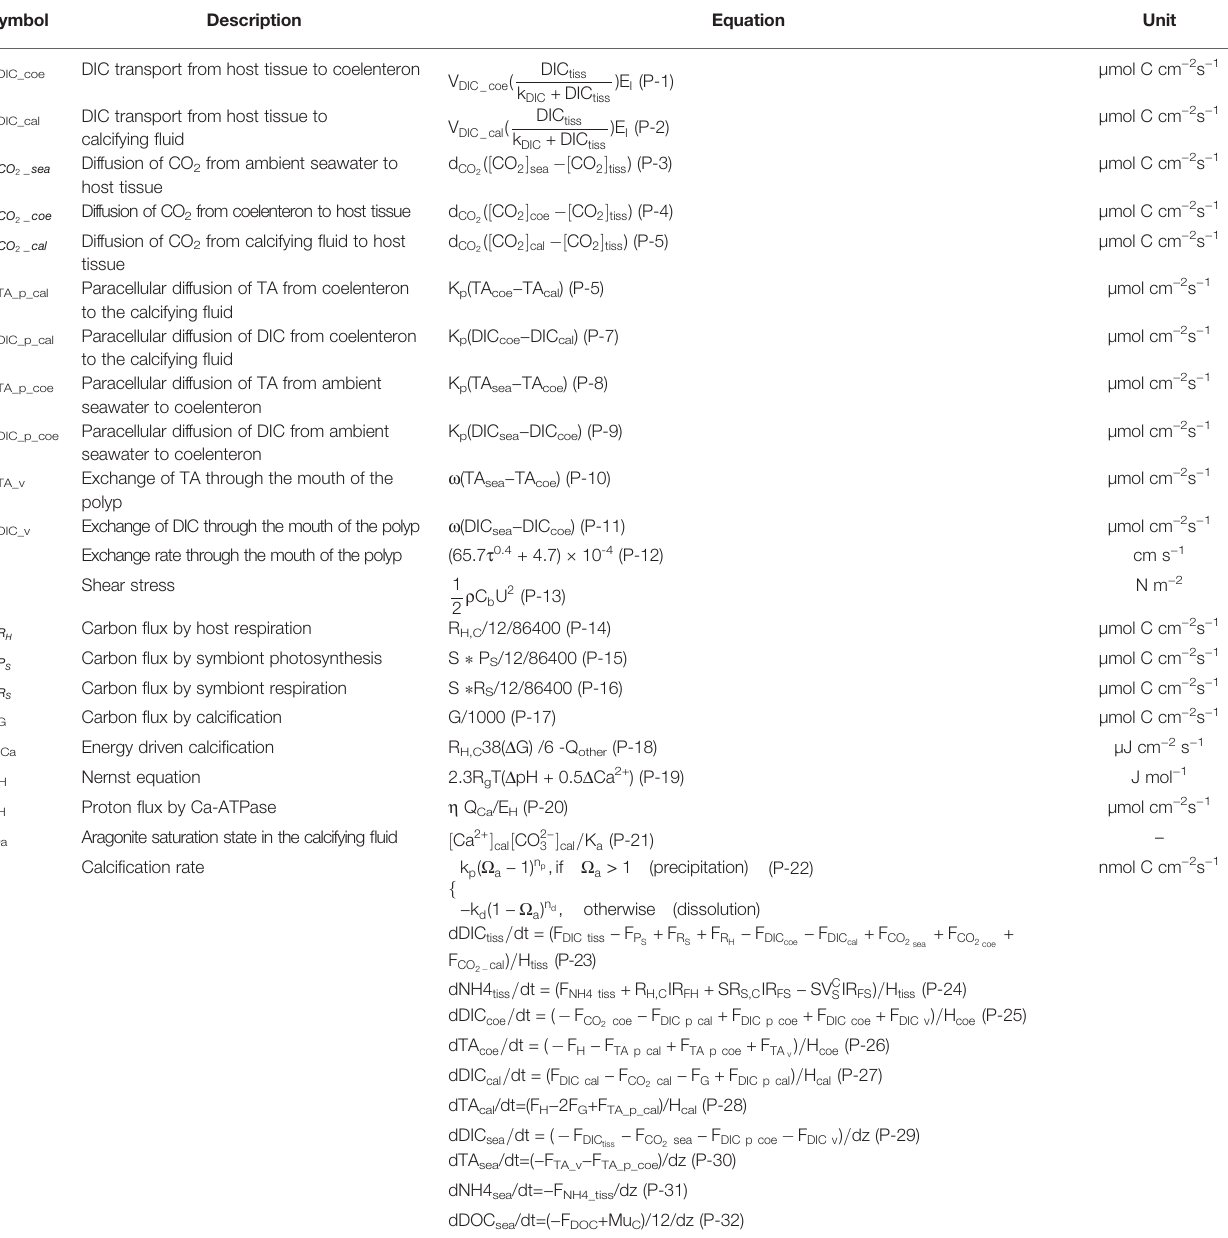
TABLE 5 | Flux terms in the coral polyp